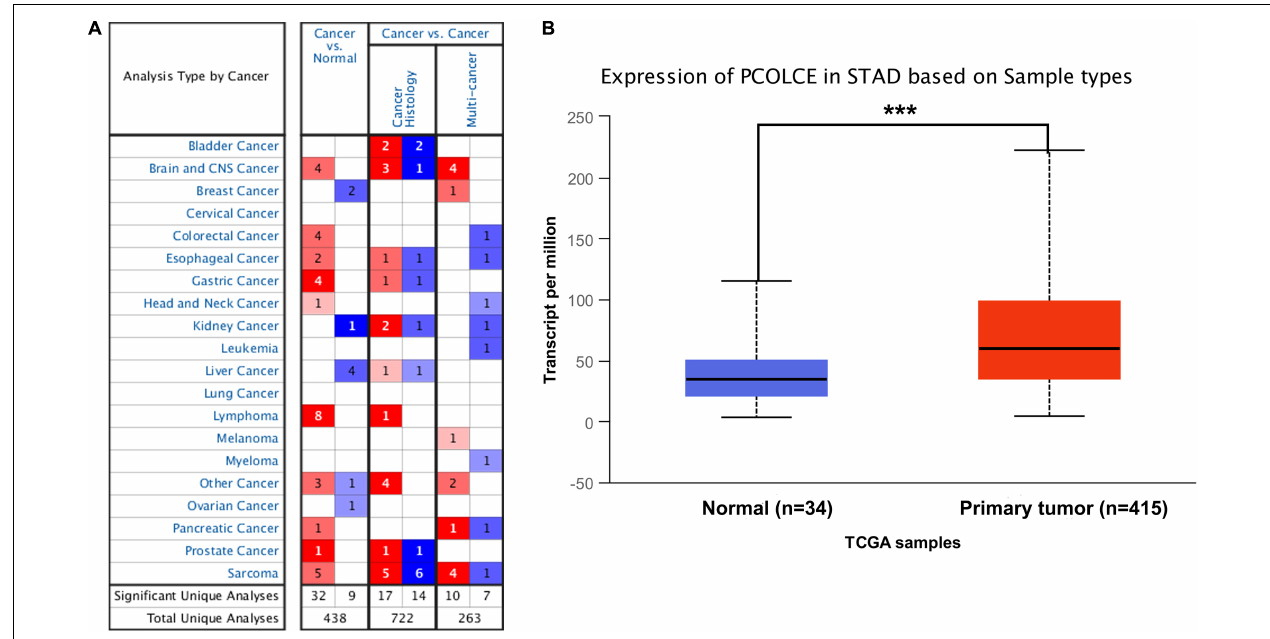
FIGURE 1 | PCOLCE expression levels in different types of human cancers. (A) Increased or decreased PCOLCE in data sets of different cancers compared with normal tissues in the Oncomine database. (B) The expression of PCOLCE was higher in STAD cancer (stomach adenocarcinoma) compared to normal stomach adenocarcinoma tissues. Data derived from UALCAN database (*** P < 0.001).